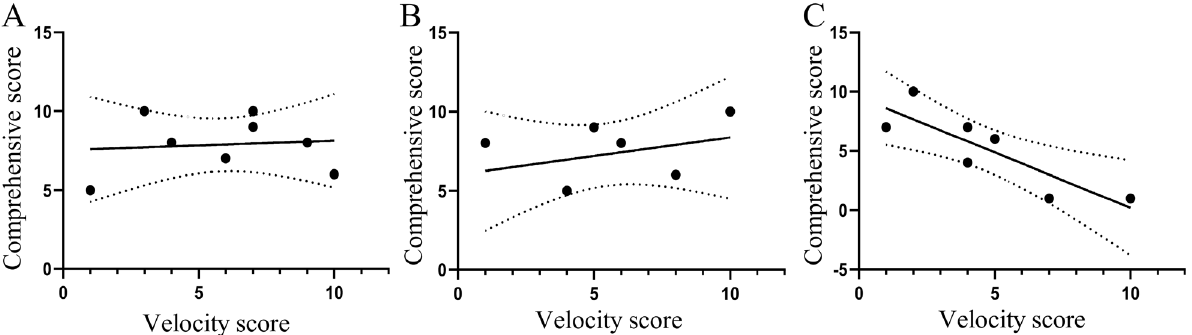
Figure 7. Correlation between the velocity score and comprehensive sand-burying score for Phrynocephalus mystaceus under the three fringe states. Note ( A ) uncut; ( B ): single cut; ( C ): double cut. The curve indicates the means with 95% confidence